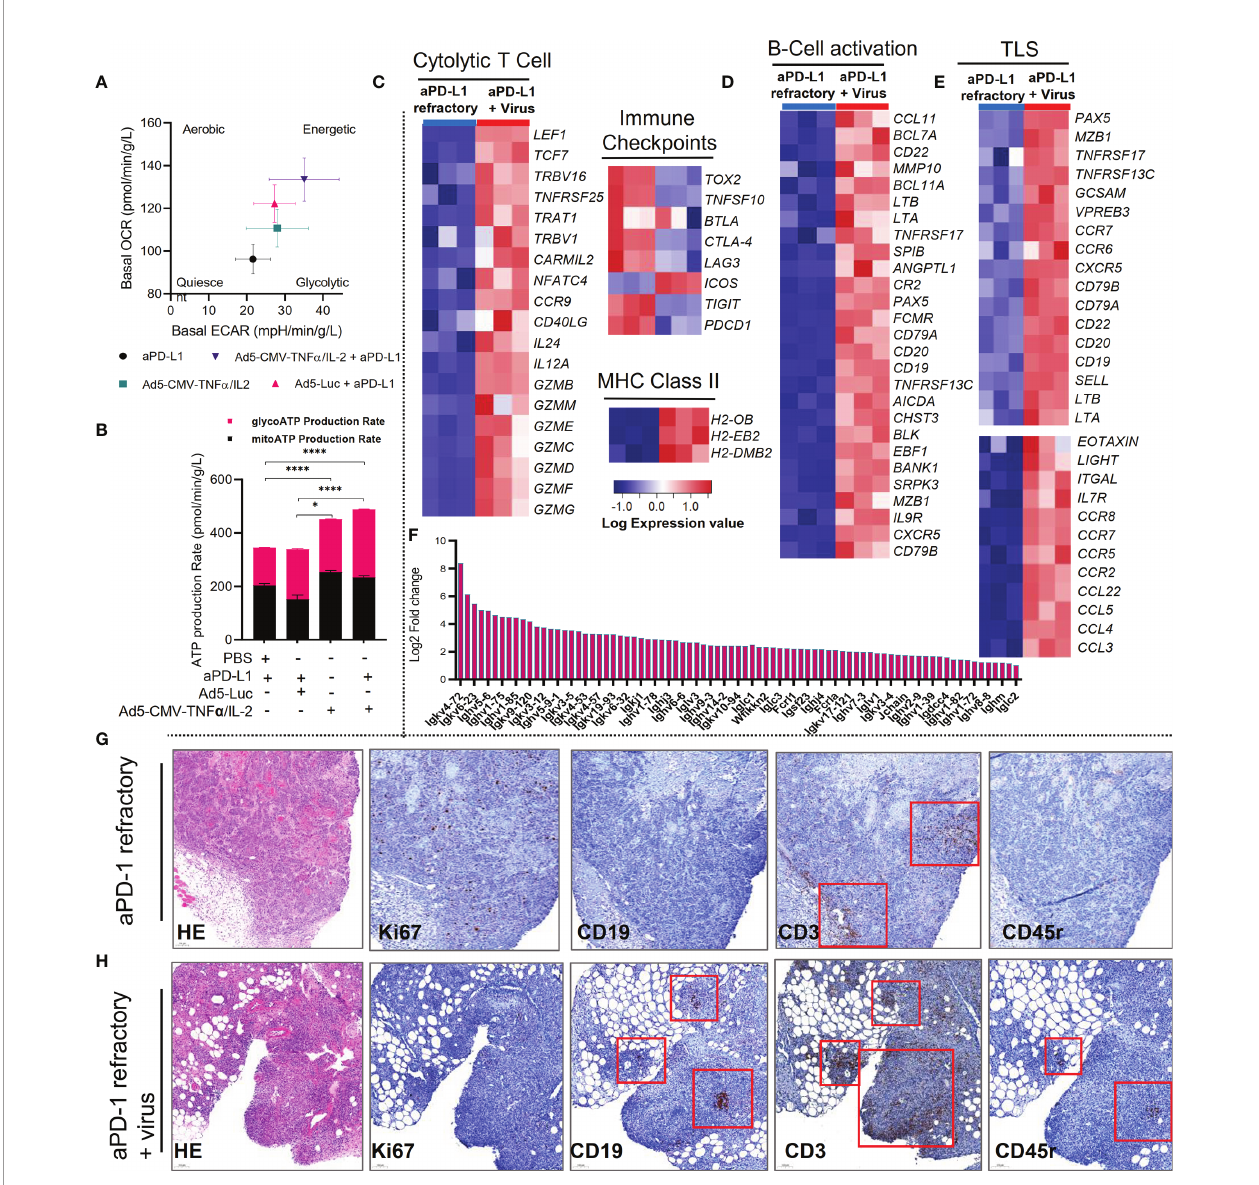
FIGURE 4 | Combining anti-PD-L1 with non-replicative Ad5-CMV-mTNF a /mIL-2 improves tumor-in fi ltrating T cell bioenergetics and addition of virus induces a tertiary lymphoid structure gene signature in MOC1 ICI refractory tumors. (A) Bioenergetics map of MOC1 anti-PD-L1 refractory tumor-in fi ltrating lymphocytes (CD3 + ) isolated by magnetic bead (negative selection) approach and analyzed by Seahorse XF analyzer. Data is presented by basal oxygen consumption rate (OCR) and extracellular acidi fi cation rate (ECAR). (B) Corresponding real-time ATP production rate by glycolysis and aerobic respiration as quanti fi ed by Seahorse XF analyzer software. (C – E) Bulk RNA-Seq of CD45 +/- populations isolated by from MOC1 anti-PD-L1 refractory tumors by magnetic bead approach. Heat maps for signi fi cantly differentially expressed genes between anti-PD-L1 refractory tumors and anti-PD-L1 refractory tumors treated with Ad5-CMV-mTNF a /mIL-2. Heat maps are organized into (C) T cell activation genes, immune checkpoints and MHC genes (D) B-cell activation genes, (E) typical tertiary lymphoid structure genes. (F) Fold change increase of signi fi cantly differentially expressed genes related to immunoglobulin synthesis between anti-PD-L1 refractory tumors and anti-PD-L1 refractory tumors treated with